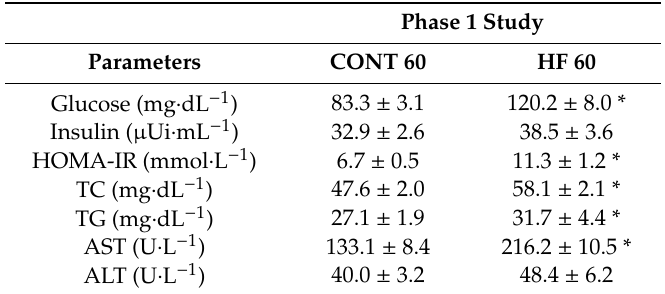
Table 2. Plasma biochemical parameters after phase 1 intake of distinct feeds.